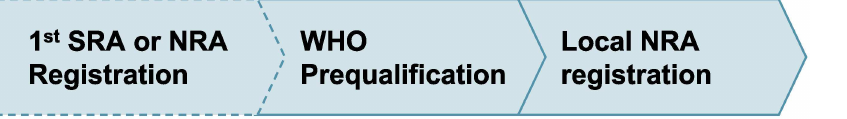
Fig 1. Three-step registration process to developing countries. For medicines, the “1 st Registration” is not requiredas a pre-requisite for WHO-PQ.